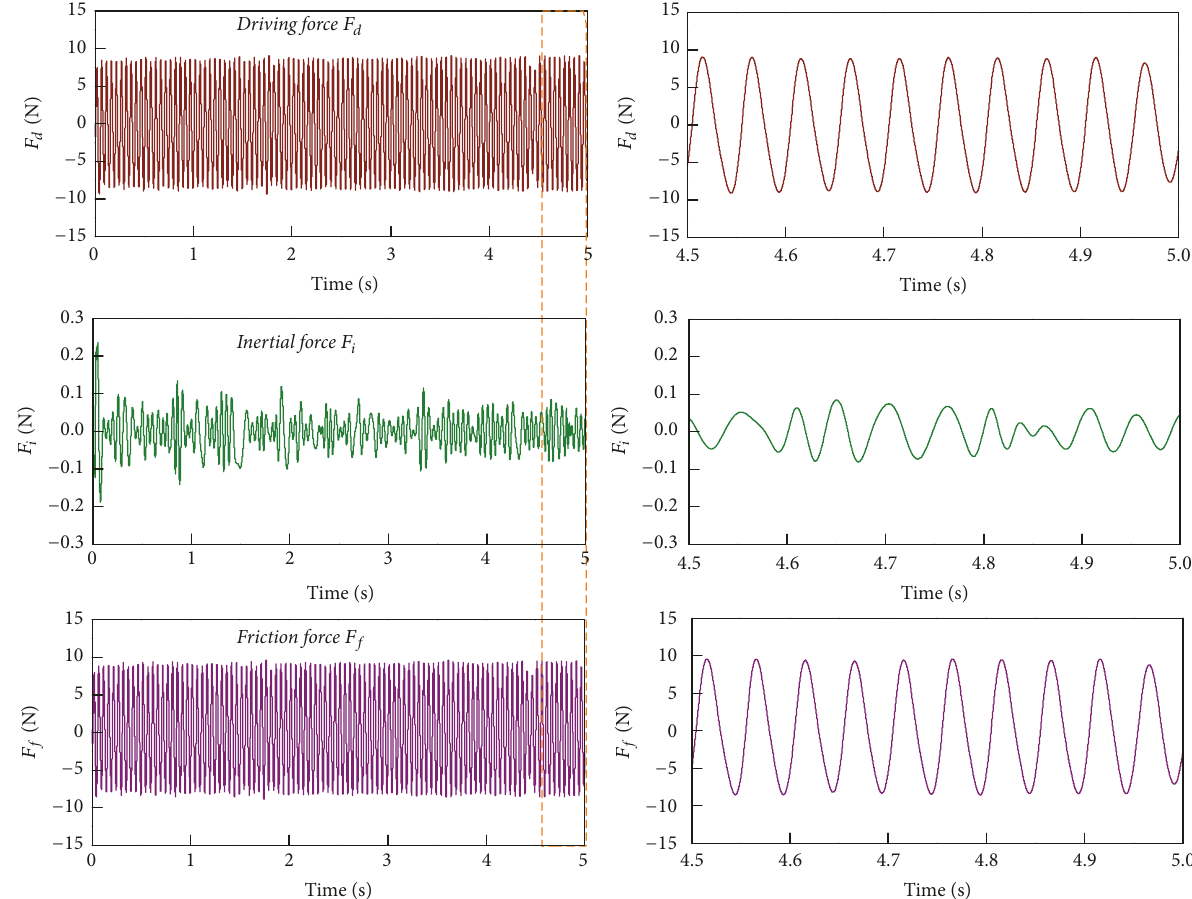
Figure 5: Experimentally determined characteristics of forces 𝐹 𝑑 , 𝐹 𝑖 , and 𝐹 𝑓 during vibrating-sliding friction coupling. Experiment parameters: OBM, 𝑢 = 4mm, 𝑓 = 20 Hz, V 𝑑 = 60 mm/s, and 𝐹 𝑁 = 30